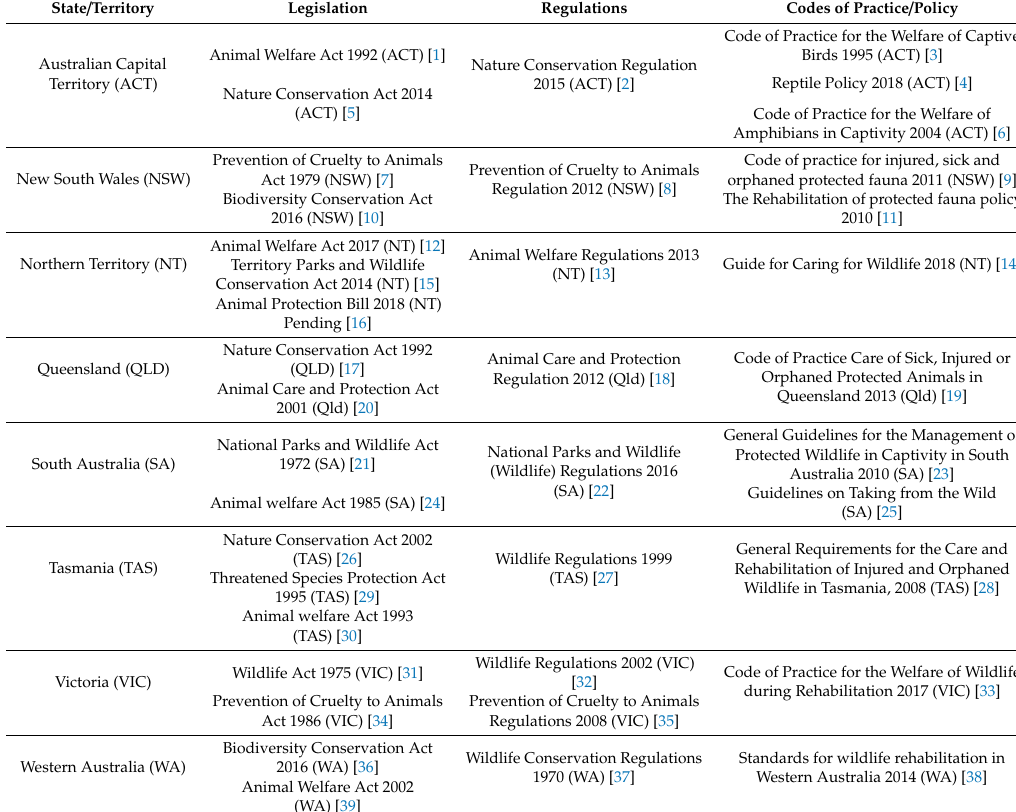
Table 1. Australian state and territory animal legislation, regulation, and codes of practice /